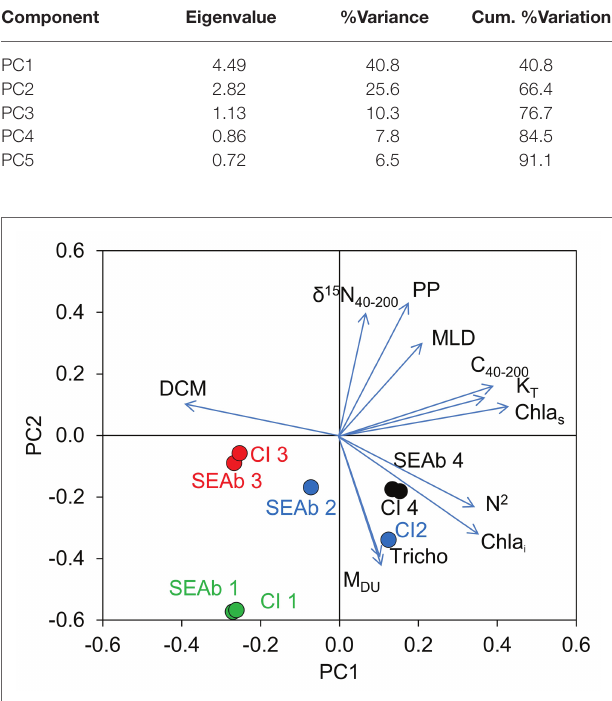
FIGURE 7 | Loadings (vectors) of the environmental variables on the space of the first (PC1) and second (PC2) components of the PCA of environmental variables determined for neuston sampling stations and projections (dots) of median values of niche size (SEAb) and 95% credible intervals (CI) of the different FGs (indicated by numbers 1–4). DCM: depth of the chlorophyll maximum (m), δ 15 N 40–200 : natural abundance of microplankton nitrogen isotopes (‰), PP: annual mean primary production (mg C m −2 d −1 ), MLD: mixed layer depth (m), C 40–200 : microplankton (40–200 μ m) carbon biomass (mg C m −3 ), K T : diffusivity due to turbulence (m 2 s −1 ), Chla s : surface chlorophyll-a (mg m −3 ), N 2 : mean squared Brunt-Väisälä frequency (s −2 ), Chla i : photic-zone integrated chlorophyll-a (mg m −2 ), Tricho: abundance of Trichodesmium (cells ml −1 ), MDU: mean monthly atmospheric dust deposition (g m −2 month −1